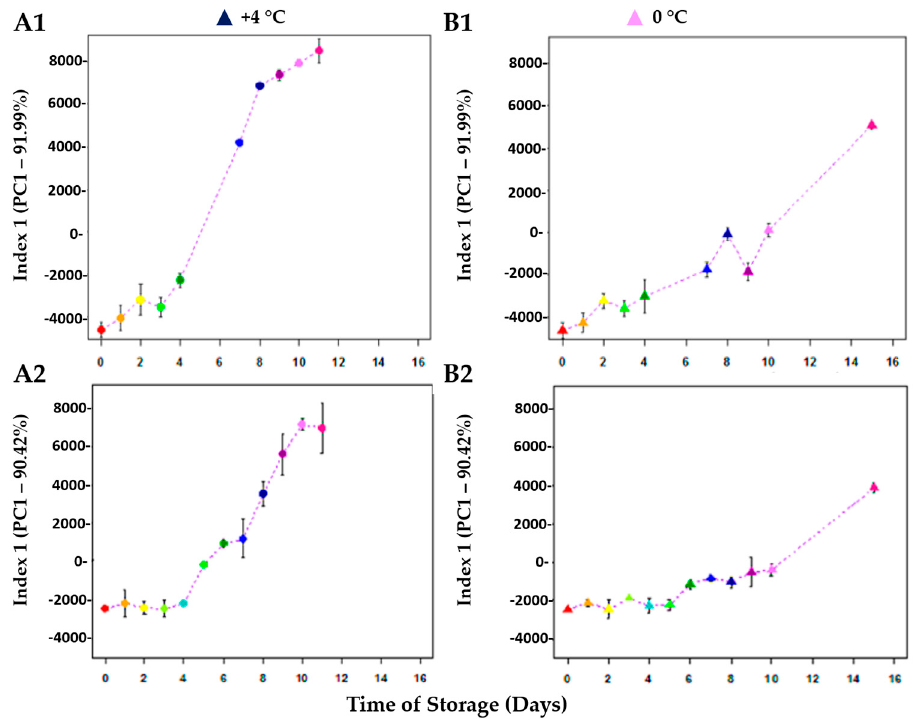
Figure 6 . Fish metabolomic freshness kinetic curves were evaluated by reporting PC1 values vs. time of storage for red mullet ( Mullus barbatus ) samples at ( A1 ) +4 °C and ( B1 ) 0 °C, and bogue ( Boobps boops ) samples at ( A2 ) +4 °C and ( B2 ) 0 °C.